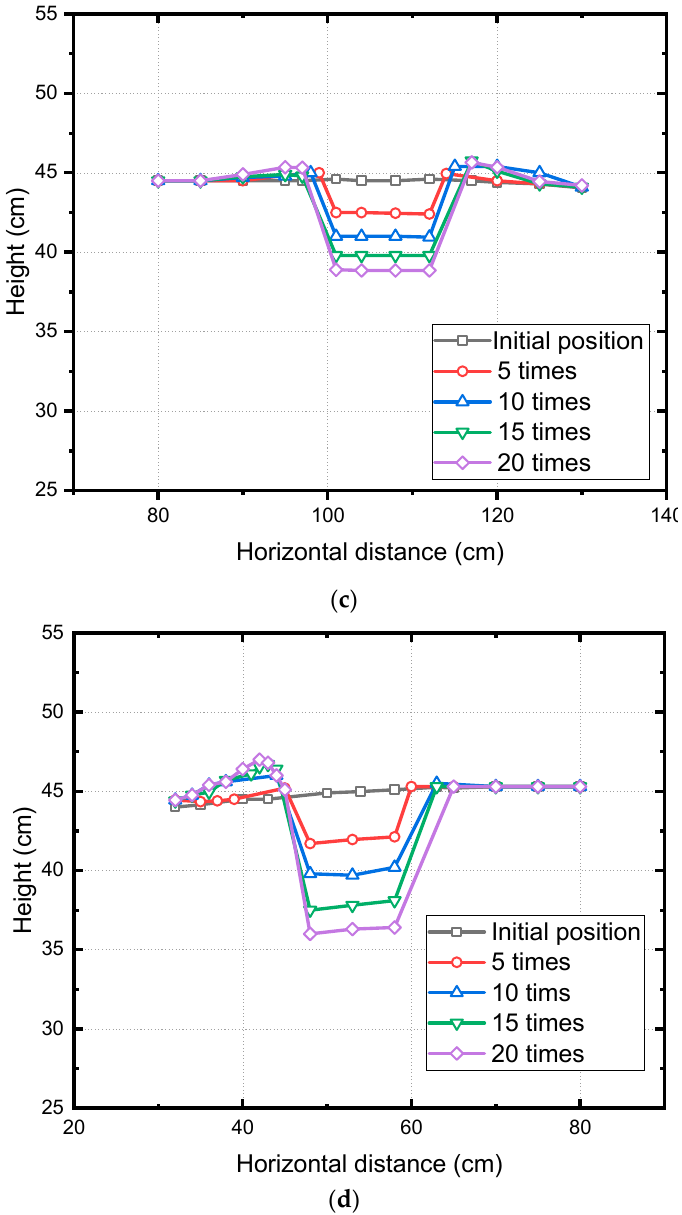
Figure 4. Changes in the crater with respect to the numbers of tamping blows for ( a ) T1, ( b ) T2, ( c ) T3, and ( d ) T4.